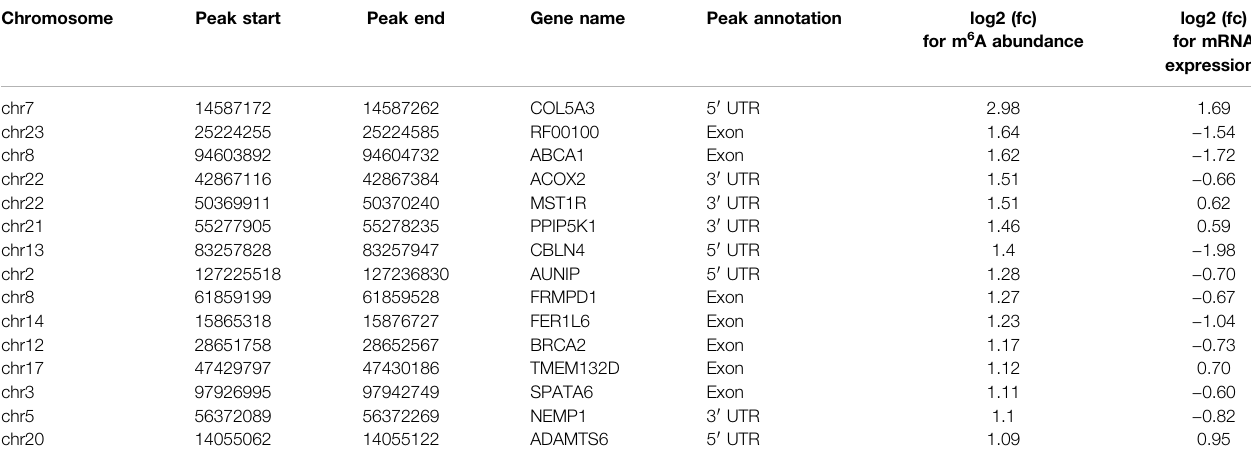
TABLE 3 | Top 15 up-regulated m 6 A methylated genes between DMGs and DEGs. Chromosome Peak start